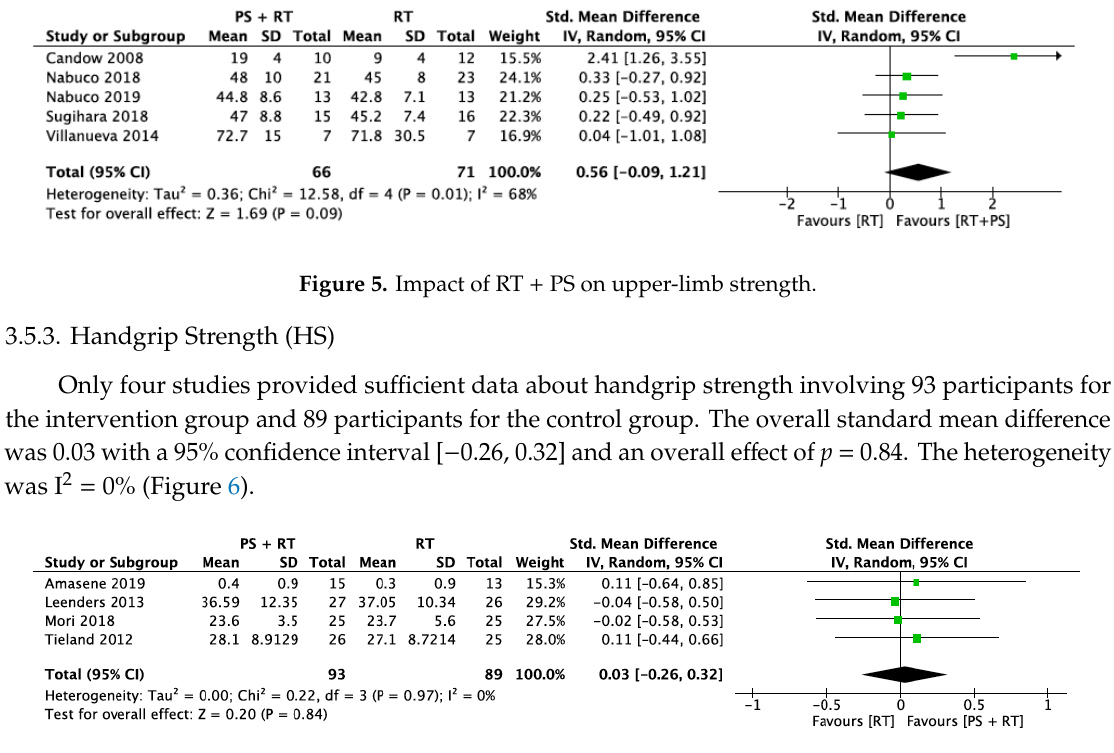
Figure 7. Impact of RT + PS on gait speed.